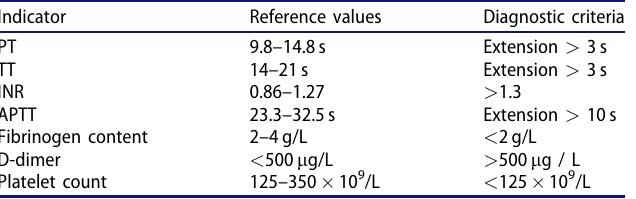
Table 1. Diagnostic criteria for